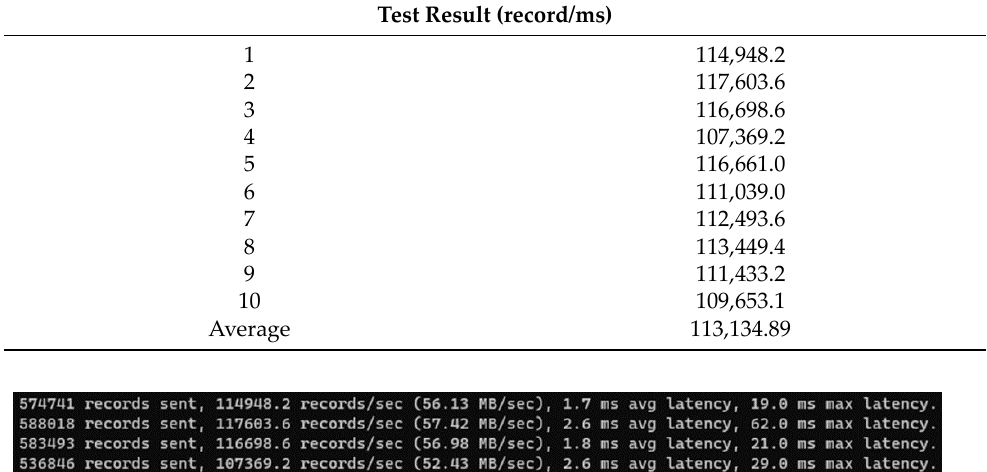
Table 10. Commands to start the Kafka performance test as a producer. Table 11. Test results during 10 times repeat.